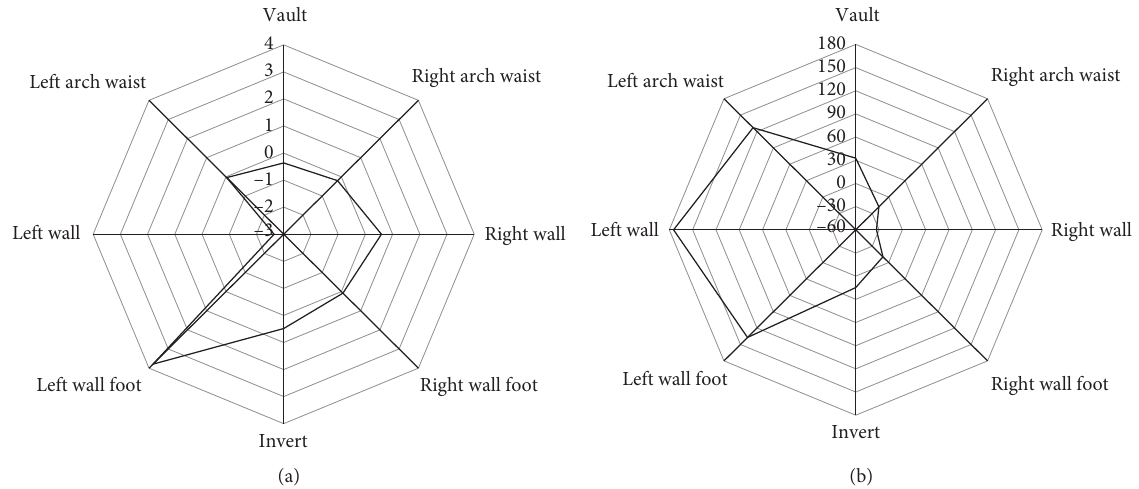
Figure 26: Additional internal force of the mining tunnel structure caused by shield tunnel. (a) Additional bending moment of the right-line mining tunnel affected by shield tunnel (unit: kN · m); (b) additional axis force of Right-line mining tunnel affected by shield tunnel (unit: